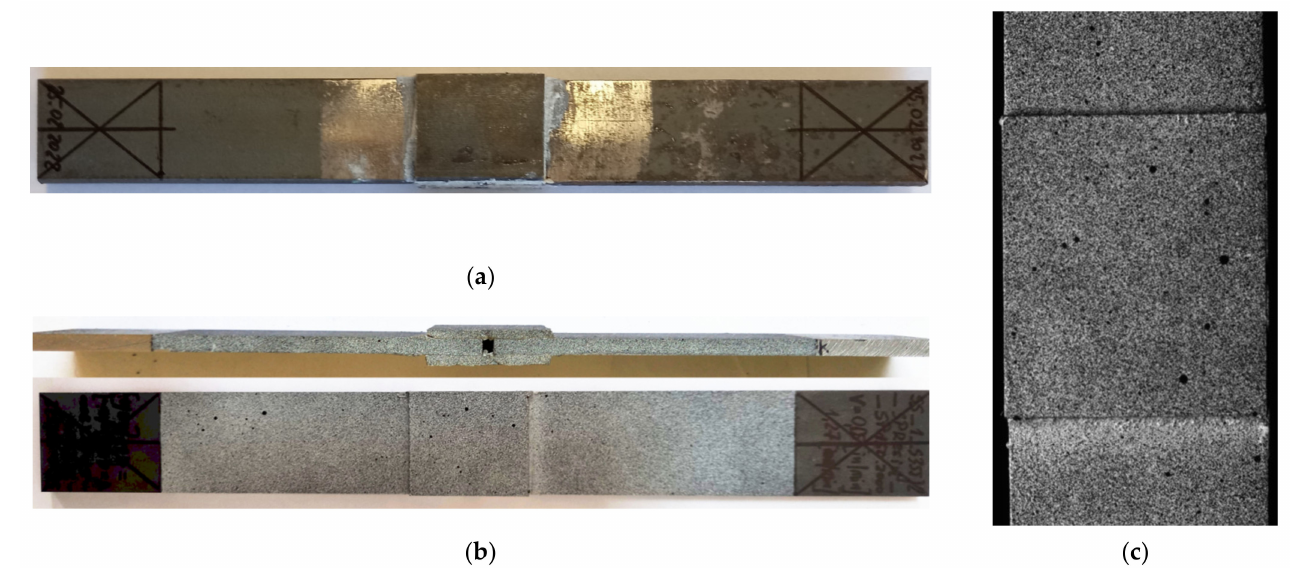
Figure 3. Samples with double-lap joint: ( a ) with metal overlay; ( b ) with composite S&P C-Laminate 150/2000 overlays; ( c ) magnification of speckle pattern on sample with composite